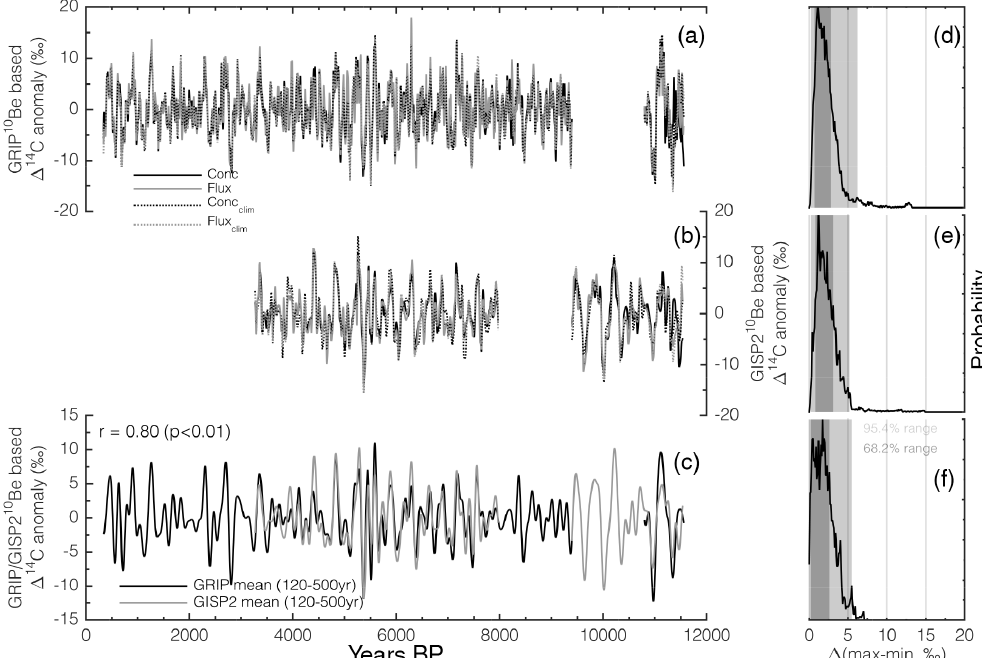
Figure 3. Centennial (<500 years) (cid:49) 14 C variations modelled from GRIP and GISP2 10 Be data. (a) and (b) show the modelled (cid:49) 14 C varia- tions from 10 Be concentrations (solid black), fluxes (solid grey), “climate corrected” concentrations (dotted black), and “climate corrected” fluxes (dotted grey) for the GRIP (a) and GISP2 (b) 10 Be records. (d) and (e) on the right side depict the probability density functions for the maximum (cid:49) 14 C difference between curves shown in (a) and (b) , respectively. (c) shows the mean of all GRIP (black) and GISP2 (grey) 10 Be based (cid:49) 14 C anomalies shown in (a) and (b) , respectively. (f) shows the corresponding probability density function of their maximum (cid:49) 14 C differences. For this comparison both ice core records have been band-pass filtered (120–500 years) to minimize inconsistencies arising from their different sampling resolution. The correlation between the GRIP and GISP2 records is given in (c) together with its p value.